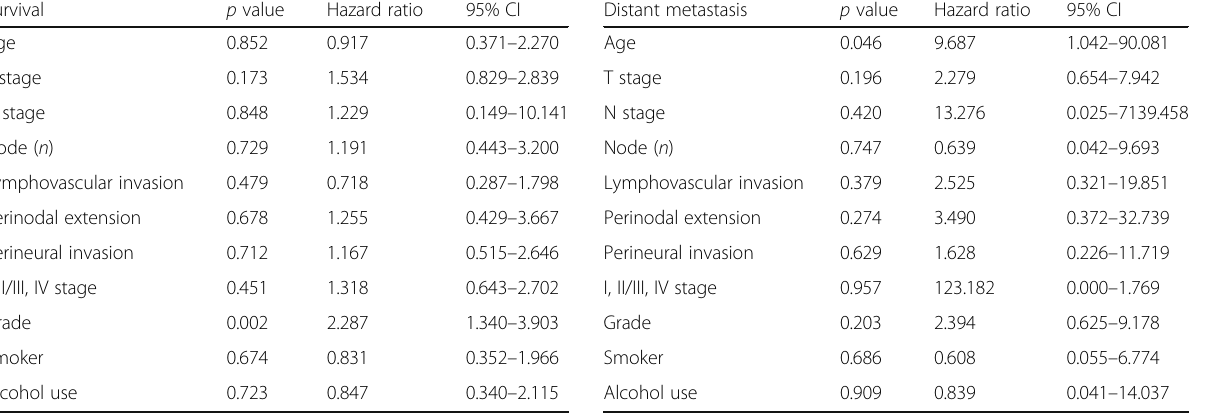
Table 4 Multivariate analysis of risk factors for distant metastasis Distant